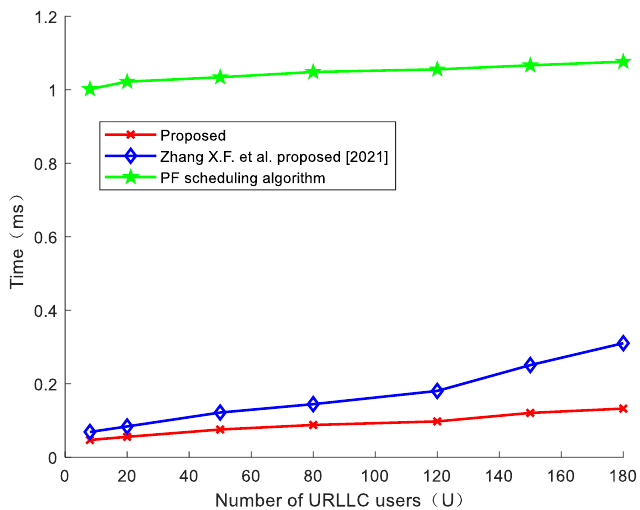
Figure 4. The time complexity of different URLLC allocation policies.